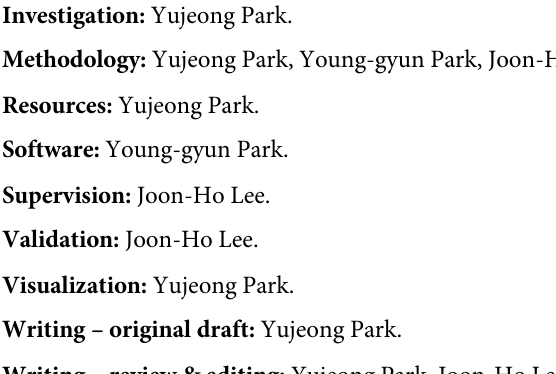
S1 Table. Genetic diversity of the B . tabaci MED treatments. S2 Table. Results of two-way ANOVA for testing effects of cluster and host plant on bio- logical parameters, body weight, and body length of B . tabaci . S3 Table. Tomato yellow leaf curl virus detected of B . tabaci MED populations in Korea from 2016 to 2018. S4 Table. Wolbachia detected of B . tabaci MED populations in Korea from 2016 to